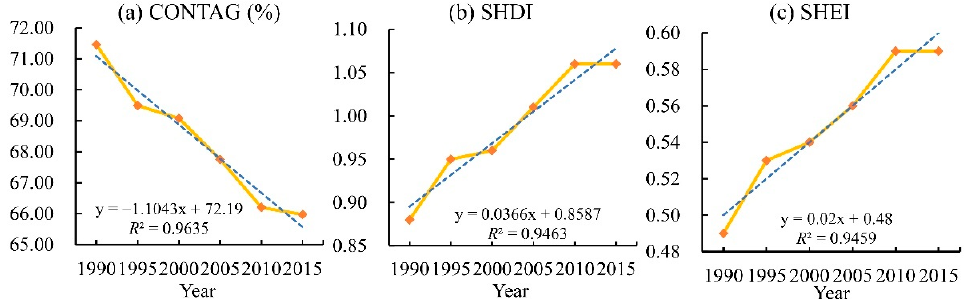
Figure 9. The landscape-level metrics of the land use pattern of Shanghai from 1990 to 2015. ( a ) Contagion index (CONTAG) of the land use pattern from 1990 to 2015; ( b ) Shannon’s evenness index (SHDI) of the land use pattern from 1990 to 2015; ( c ) Shannon’s evenness index (SHEI) of the land use pattern from 1990 to 2015.